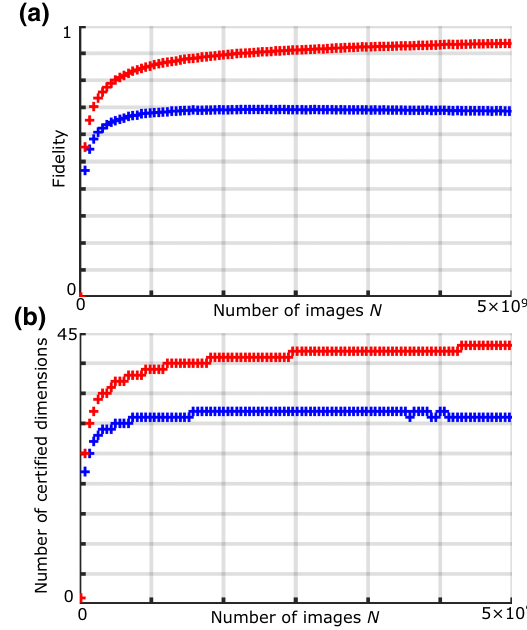
FIG. 12. The simulated fidelity and number of certified dimen- sions as a function of the number of frames. (a) The fidelity as a function of the number of frames N in the case of a maxi- mally entangled state (blue) and a nonmaximally entangled state (red). (b) The number of certified dimensions as a function of the number of frames N in the case of a maximally entangled state (blue) and a nonmaximally entangled state (red). The simulations parameters are α = 1 / 45, α (cid:11) = 0.0001, and K =